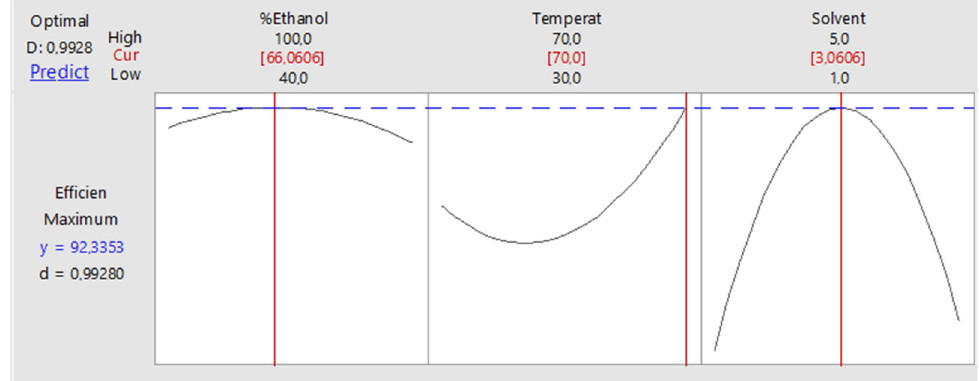
( b ) ( c ) Figure 3. Surface and contour plots showing percentage recovery as function of the effects temper- ature and solvent ratio while keeping percentage ethanol constant ( a ); effects of percentage ethanol and solvent ratio while keeping temperature constant ( b ); and effects of percentage ethanol and temperature while keeping solvent ratio constant ( c ). 2.3. Testing the Predicted Optimum Conditions The optimizer in the Minitab software was used to predict the optimum conditions for each independent factor (Figure 4). The setting for the independent factors was so that they should be maximized. The optimum conditions that were predicted are percentage ethanol (66.1%), temperature (70 °C) and solvent to sample ratio (3 mL: 50 mg) and the predicted de- sirability functions was 0.9928. These conditions were tested by extracting the compounds of interest under the predicted optimum conditions. The results that were obtained were used to calculate the desirability function. The practical and predicted desirability functions were compared and the percentage difference was calculated. The calculated desirability function was 0.9773, comparing that with the predicted desirability function, the percentage difference